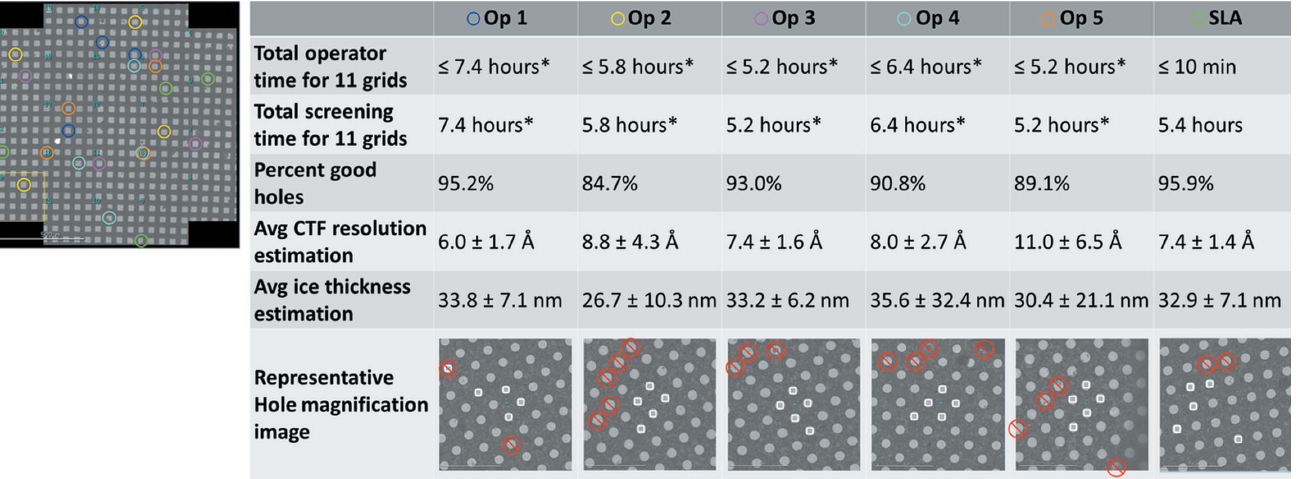
Figure 2 Quantitative comparisons between Smart Leginon Autoscreen ( SLA ) and expert microscope operators (Op). Autoscreen and operators each independently selected what they considered to be the ‘best’ 4 squares, where for Autoscreen each square was selected from 4 equally spaced square area ranges spanning all square areas (one grid atlas is shown on the left; see Fig. S8 for all atlases). Autoscreen took <10 min for the operator to set up and then run in a completely unattended manner for 5.4 h. The operators spend an average of 6.0 h to screen 11 grids (*extrapolated from 3 grids), of which most of the time is spent operating the microscope, interspersed with several short periods (5–10 min per grid) of time away from the microscope. (Note: calculations assume that the operators do not take any breaks away from the microscope.) In terms of percentage of good holes available from hole magnification images, Autoscreen (95.9% good holes) performed better than the average from the operators (90.6% good holes) and comparable to the best operator (95.2% good holes). Figs. S9–S14 show visual analyses of all holes and Table 1 shows the quantifications. From the random holes targeted ( SLA ) and central holes (Op), CTF resolution estimation for Autoscreen holes (7.3 (cid:7) 2.6 A˚ ) was comparable to the average obtained by operators (7.4 (cid:7) 2.9 A˚ ). Estimates of ice thickness show comparable values between Autoscreen (32.9 (cid:7) 7.1 nm) and operators (35.0 (cid:7) 18.7 nm). Table S1 shows the raw data. The hole magnification image most representative of the average in terms of hole quality is shown in the last row. Targets are shown by white squares and bad holes are shown by red circles with lines through them. Note: the representative image for operator 4 is a composite image due to there being no image that closely represents the